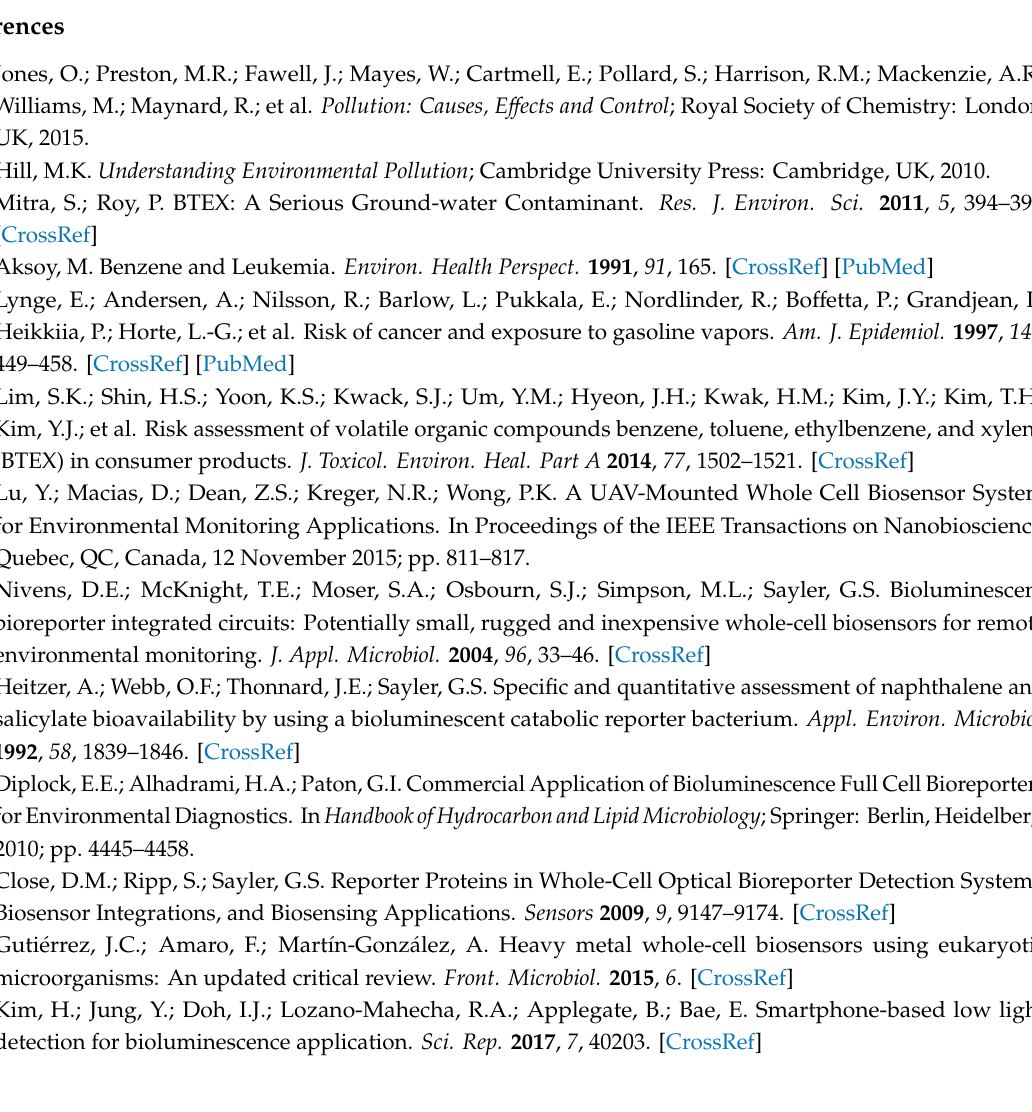
Figure S1: Scheme of OFEs preparation with description; Figure S2: Quartz cones; Video S1: Video record of bioluminescence of Pseudomonas putida TVA8 attached on quartz cone. Video recorded for 17 h and accelerated to 20 s; Table S1: Integrals of intensities and maxima of bioluminescence for five OFEs; Figure S3: Plotted geometrical shape of five theoretical OFEs with identical Dmax, Dmin, (radius r) and length L, but di ff erent shape (bent), OFE models were used to calculate their transmittances; Figure S4: Calculated transmittances of the five theoretical OFEs based on their geometrical